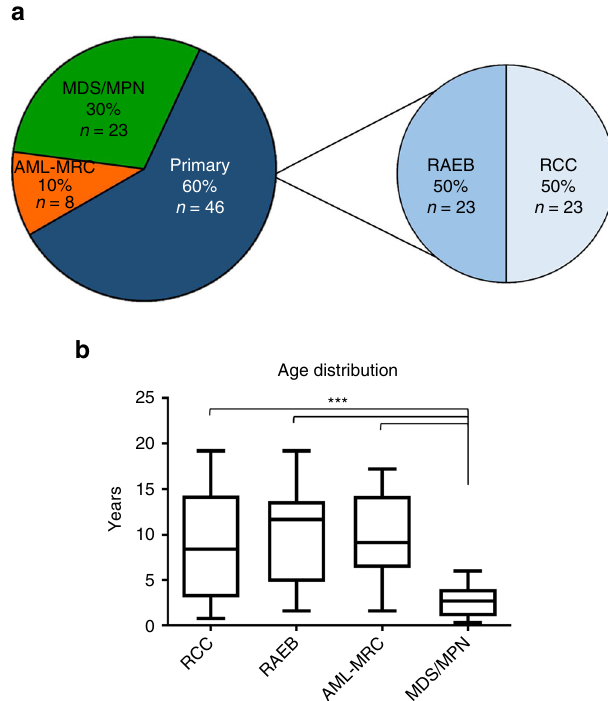
Fig. 1 Pediatric MDS cohort. a Pie charts depicting the distribution of the three diagnostic categories and subcategories of the pediatric MDS cohort; Total: n = 77. b Distribution of age (in years) at diagnosis for the pediatric MDS cohort. Lines within boxes represent median age (RCC: 8.4, RAEB: 11.7, AML-MRC: 9.1, MDS/MPN: 2.7) and whiskers represent maximum and minimum. *** : p < 0.0001 (student ’ s t -test). AML-MRC AML with myelodysplasia-related changes, RAEB, Refractory anemia with excess blasts; RCC, Refractory cytopenia of